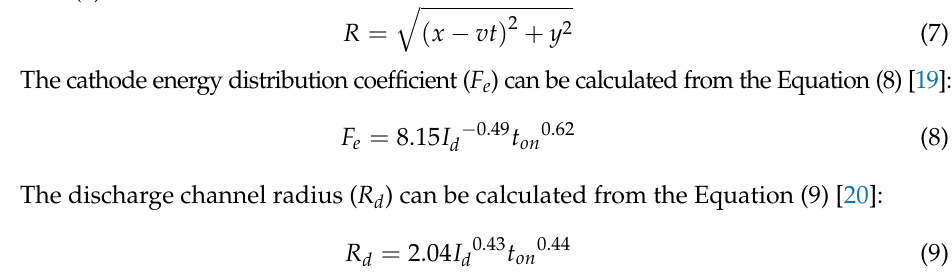
Table 2. Discharge current at different voltages.